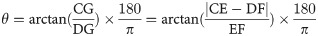
Measurement of the anterior chamber depth (ACD) and intraocular lens (IOL) decentration and tilt on the ultrasound biomicroscopy image of the anterior segment.ACD was determined from the central inner corneal surface, perpendicular to the corneal surface to the most anteriorly visible part of the IOL. A line (line AB) was drawn between the two scleral spurs (SSs), as the base line of reference for IOL position. Two perpendicular lines were drawn from both optical endpoints of the IOL (C and D) to the base line with intersection points (E and F). IOL decentration was equal to half of the differences between distance AE and FB, i.e. IOL decentration = (|AE—FB|) / 2. IOL tilt was determined by the angle (θ) formed by the line between the two optical endpoints and the base line. A line parallel to line AB was drawn intersecting one of the optical endpoints (D). Angle θ was calculated with following formula:
θ=arctan⁡(CGDG)×180π=arctan⁡(|CE−DF|EF)×180π